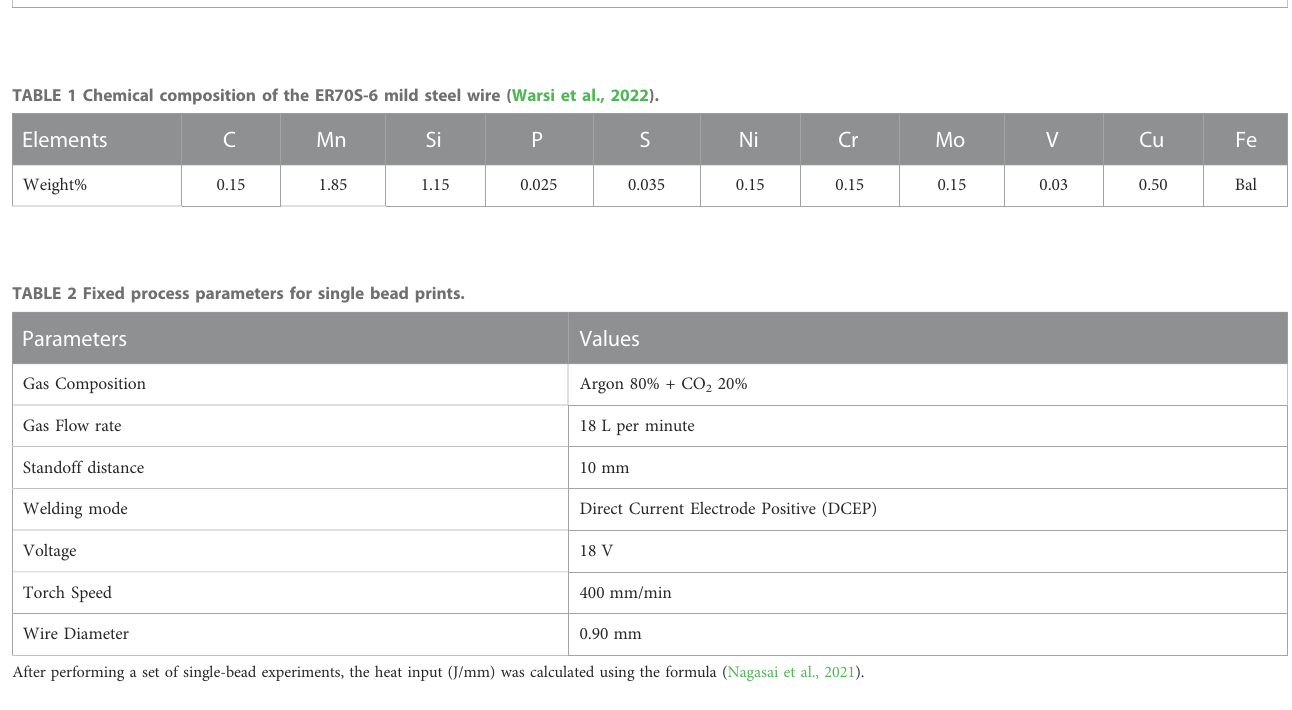
Figure 1. The welding torch of the MIG equipment was mounted on the Z -axis spindle of the CNC machine for the printing process, as